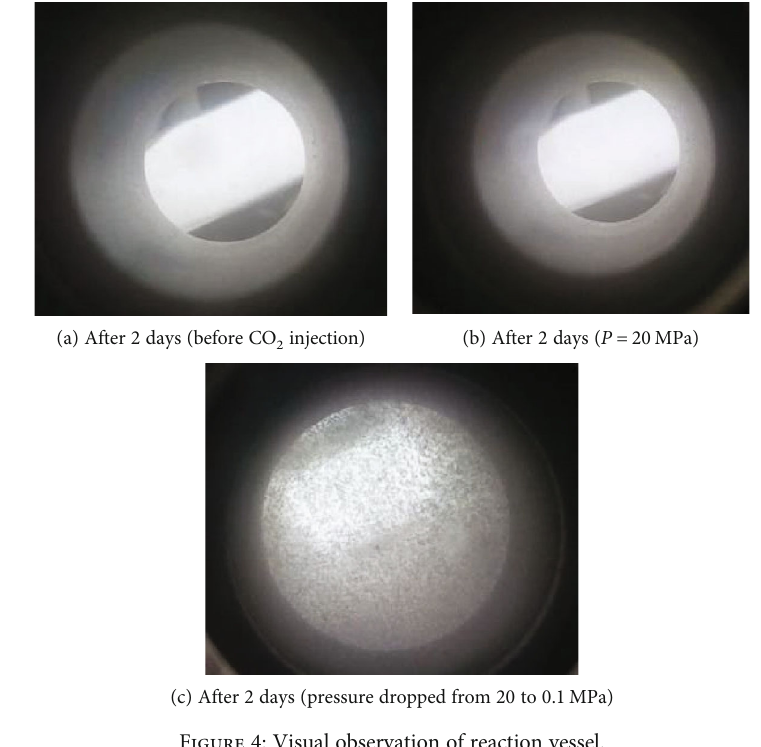
Figure 4: Visual observation of reaction